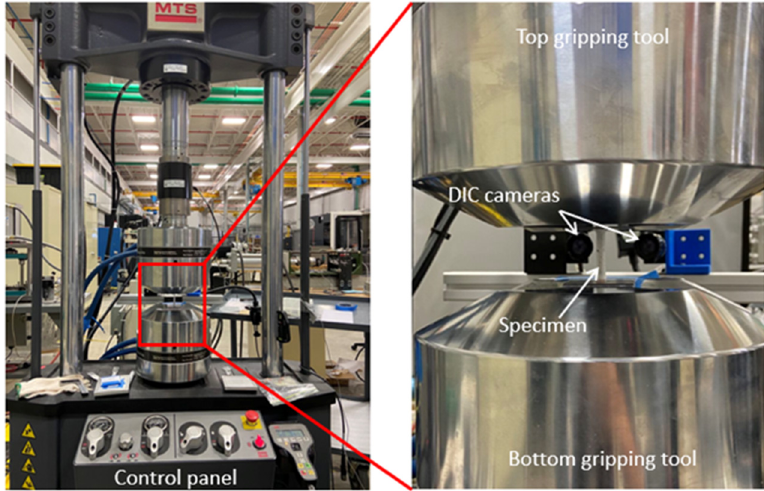
Figure 2. Tensile tests on MTS machine with DIC system.